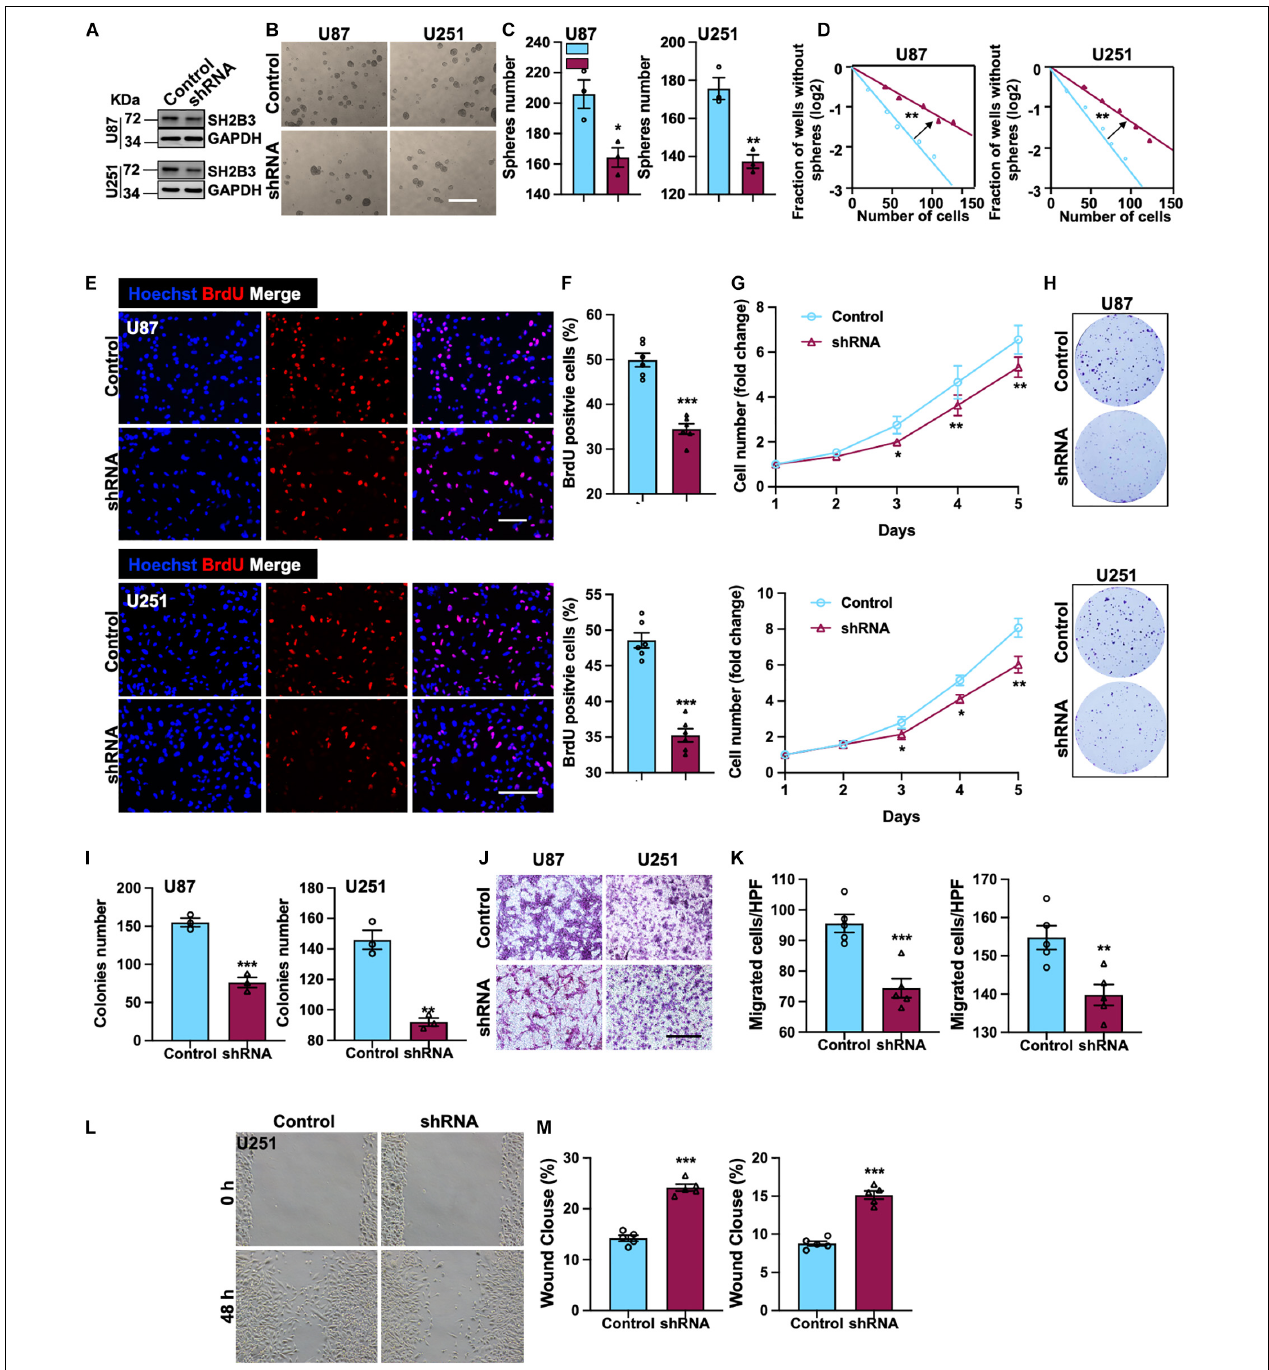
FIGURE 3 | SH2B3 is required for GSCs’ self-renewal and GBM cell proliferation and migration. (A) Expression pattern of SH2B3 in indicated control or shSH2B3 cells. (B) Tumor spheres formation ability was inhibited by depleting SH2B3, and representative images of tumor spheres from indicated cells were shown. Scale bar = 500 µ m. (C) Quantification data for panel (B) . (D) Indicated derived cell tumor spheres formation ability was repressed by depleting SH2B3 as determined by in vitro limiting dilution assay, and the quantification data were shown. (E) Immunofluorescence staining of BrdU positive cells in indicated cells and representative images were shown. Red dye represents proliferating cells. Scale bar = 100 µ m. (F) Quantification data for panel (E) . (G) The cell proliferation rate of indicated cells expressing with or without SH2B3 shRNA. (H) Colony formation ability was inhibited by depleting SH2B3, and representative images of colonies derived from indicated cells were shown. (I) Quantification data for panel (H) . (J) Migration ability of indicated cells expressing with or without SH2B3 shRNA and representative images of migrated cells were shown. Scale bar = 100 µ m. (K) Quantification data for panel (J) . (L) Indicated cells migration ability was inhibited by silencing of SH2B3 as assessed by wound healing assay, and representative images were shown. (M) Quantification data were shown. Control or shRNA means indicated cells expressing control shRNA or SH2B3 shRNA, respectively. *, **, and *** indicate p < 0.05, p < 0.01, and p < 0.0001, respectively.